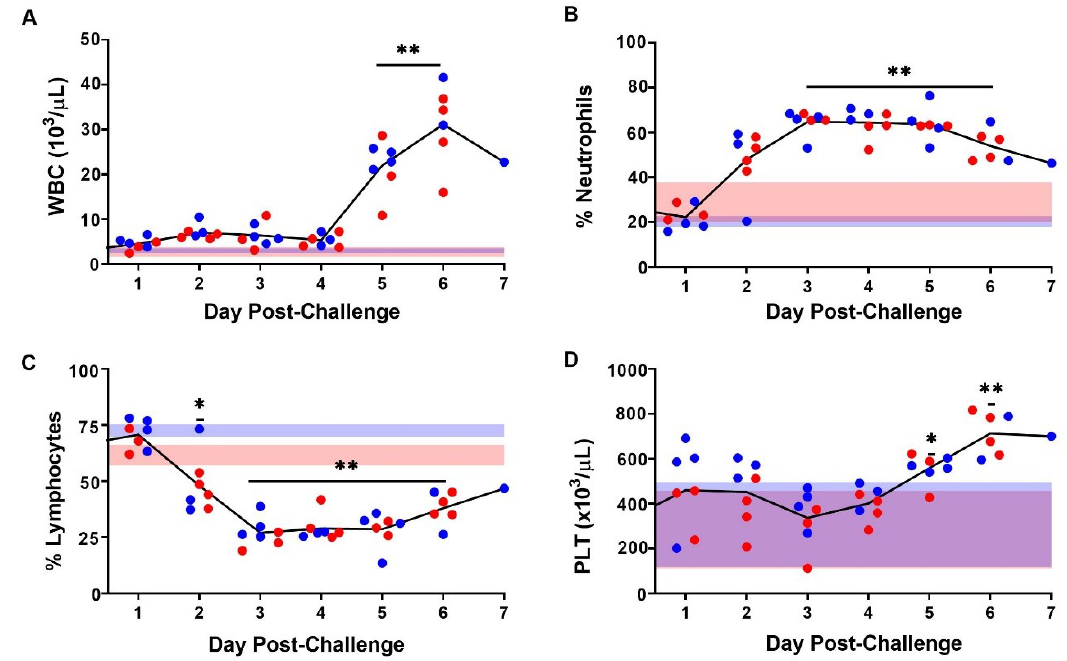
Figure 4. Hematological Changes following SUDV Challenge in STAT-1 KO Mice. Black lines represent average white blood cell count (WBC) ( A ), percent of neutrophils ( B ) percent of lymphocytes ( C ), and platelet counts (PLT) ( D ). Symbols ( • and • ) represent individual values from a female or male mouse, respectively. Single (*) and double asterisks (**) indicate statistical differences of p < 0.05 and p < 0.001, respectively, as compared to mice processed on day 0.